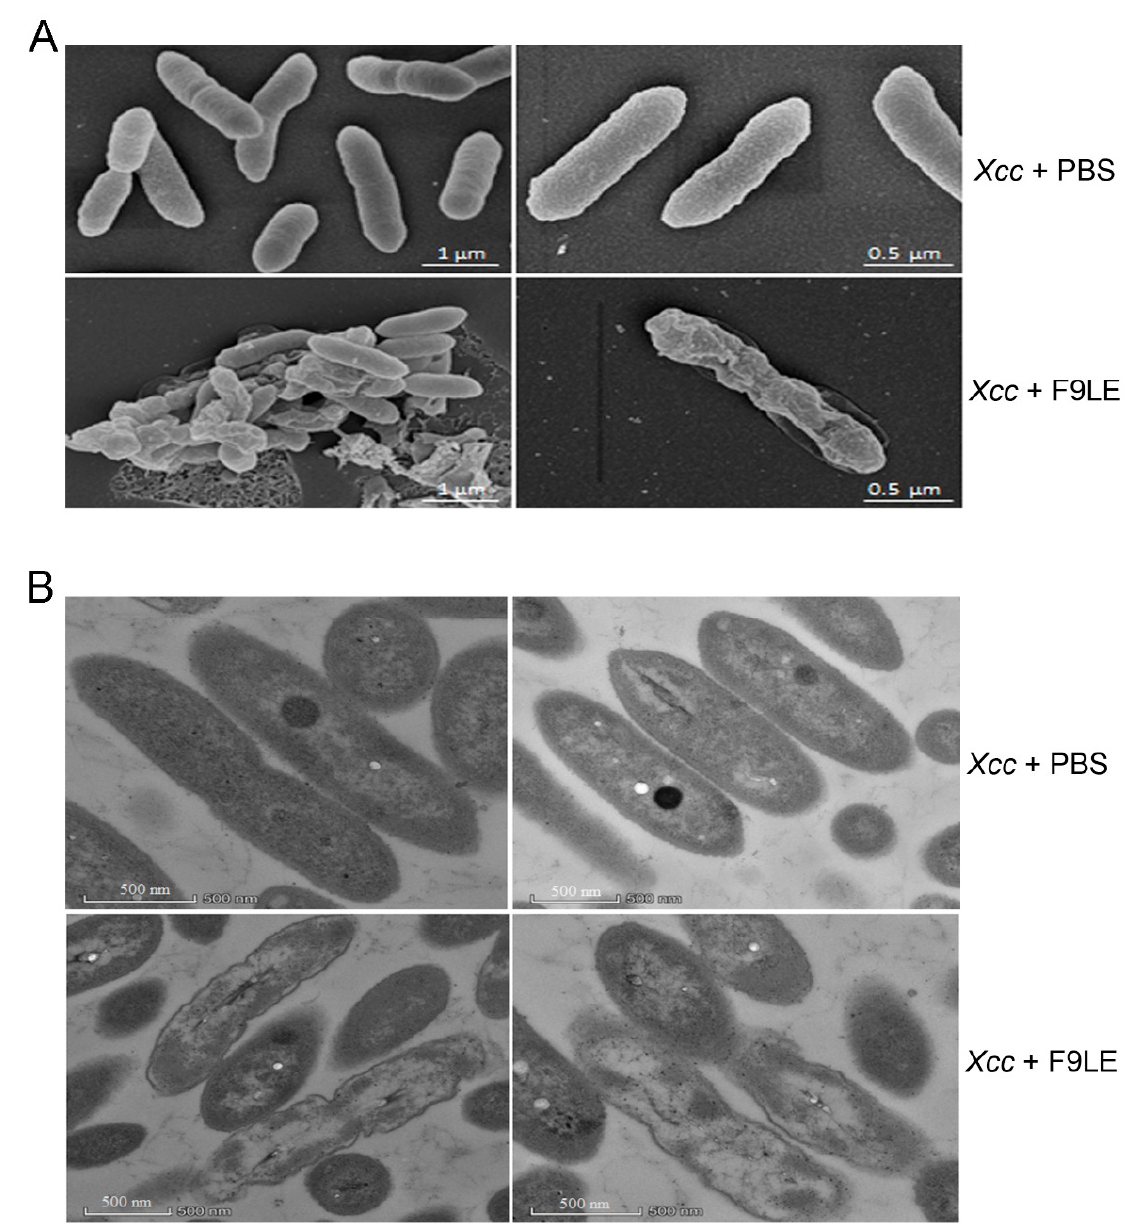
Figure 3. Photographs showing morphological and ultrastructural changes caused by bacteriostatic lipopeptide extract by scanning electron microscopy and transmission electron microscopy. ( A ) The morphological changes of Xcc jx-6 cells after exposure to F9LE (200 µg/mL) for 12 h were observed by SEM. ( B ) The ultrastructural changes of Xcc jx-6 cells treated with F9LE (200 µg/mL) for 12 h were observed by TEM.